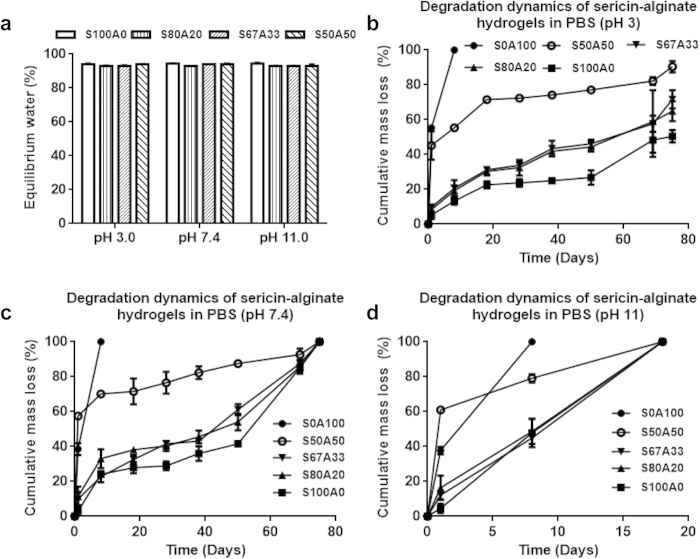
The swelling behavior and degradation kinetics of the sericin-alginate IPN hydrogels.(a) The equilibrium water content of the IPN hydrogels 24 hours after immersion into PBS with different pH (3, 7.4, 11) at 37 °C (n = 3 per group). (b, c, d) The cumulative weight loss of the IPN hydrogels over time in PBS with different pH (3, 7.4, 11) at 37 °C (n = 3 per group per time point).